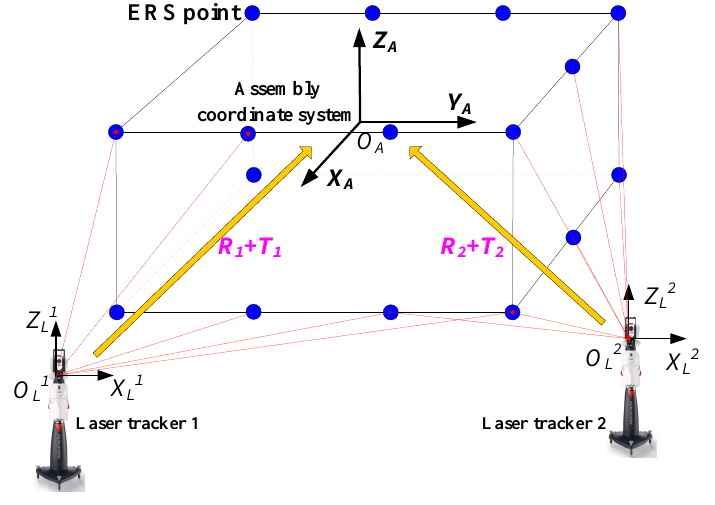
Figure 1. The measurement principle in large-scale aircraft assembly